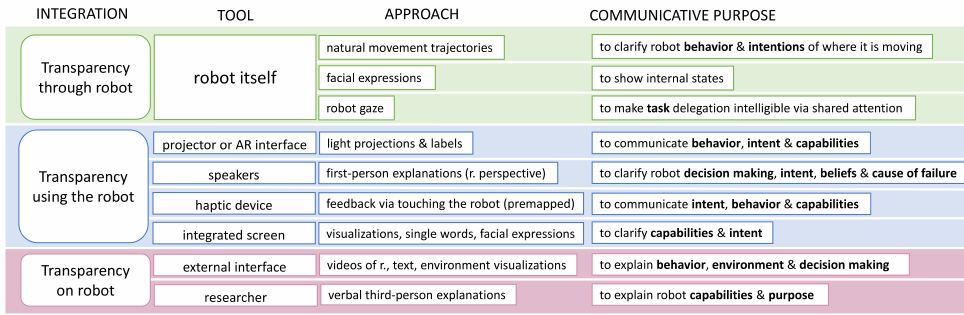
Figure 3. The classification presents the observed best practices of how to present information to make a robot transparent. We map the approaches based on their integration into the robot design. The robot property made transparent is linked to technical